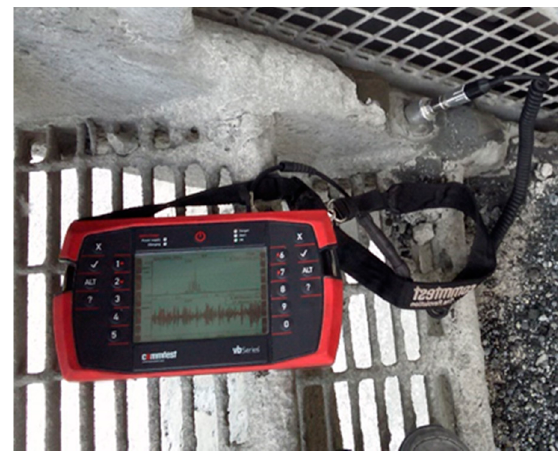
Figure 14. Vibration measurements.